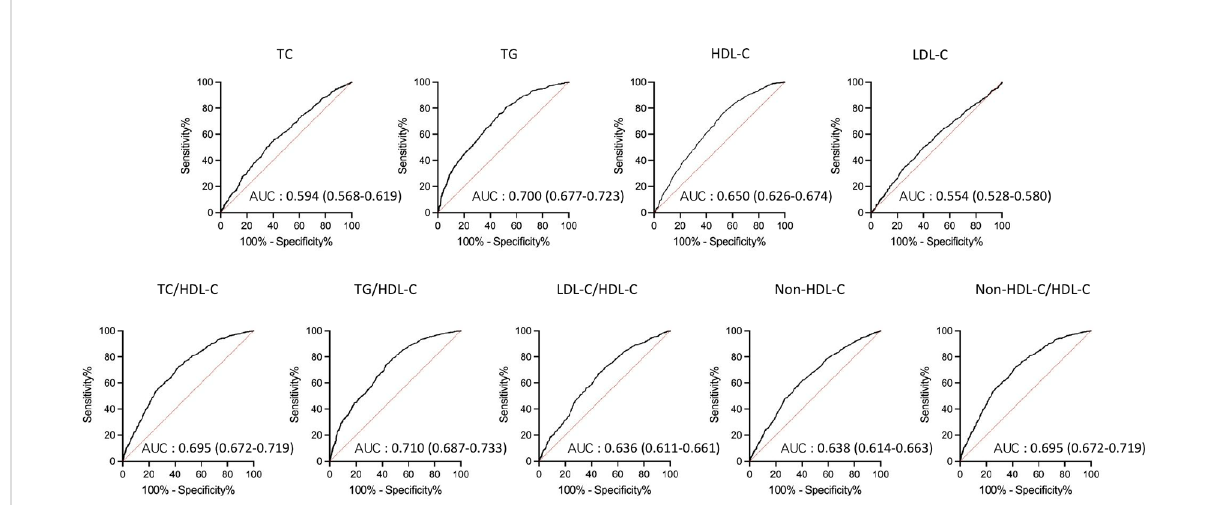
FIGURE 1 Receiver operating characteristic (ROC) curves of lipid parameters for detecting non-alcoholic fatty liver disease in T2DM patients. AUC, area under the curve; TC, total cholesterol; TG, triglycerides; HDL-C, high density lipoprotein cholesterol; LDL-C, low density lipoprotein cholesterol; T2DM, type 2 diabetes